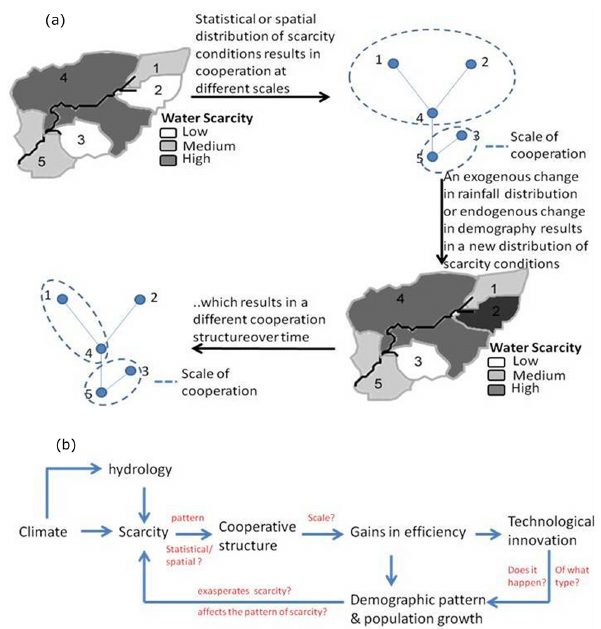
Fig. 3. Illustrations of the theory of endogenous change.